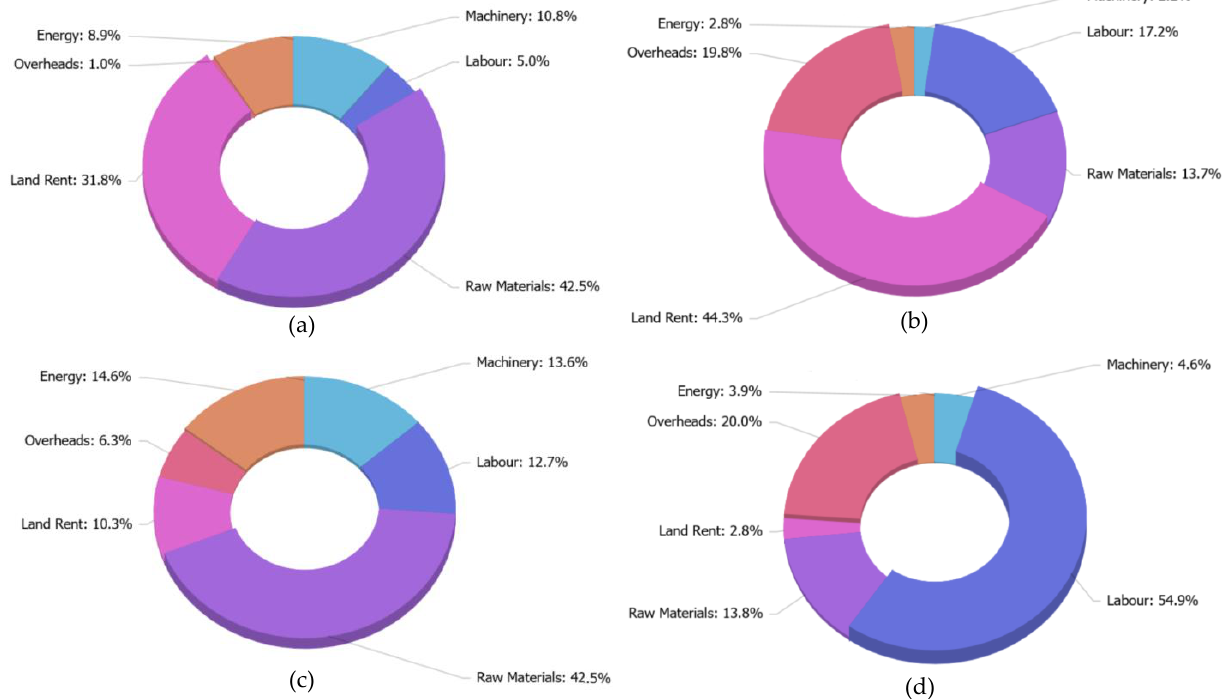
Figure 3. Shares of costs according to the LCC economic analysis for ( a ) Barley fodder ( b ) Olive trees, ( c ) Barley and olive trees and ( d ) Vetch–Barley and olive trees.